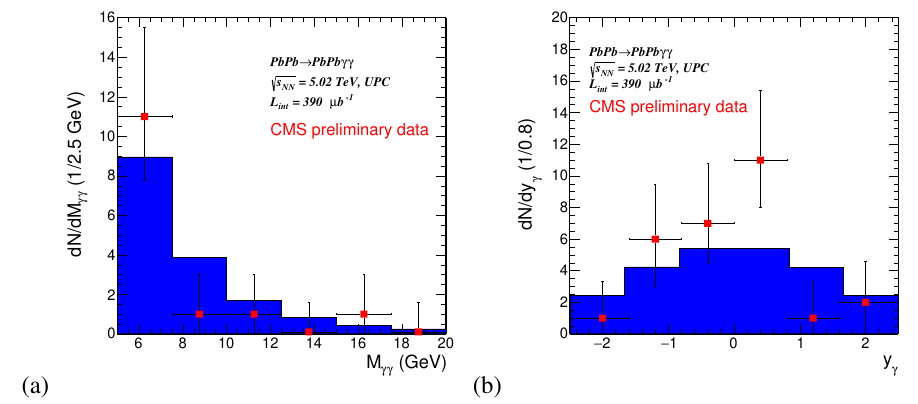
Figure 6. Comparison of our results with existing CMS preliminary data [18]. (a) Distribution in invariant mass of diphoton pair. (b) Rapidity of single outgoing photon.